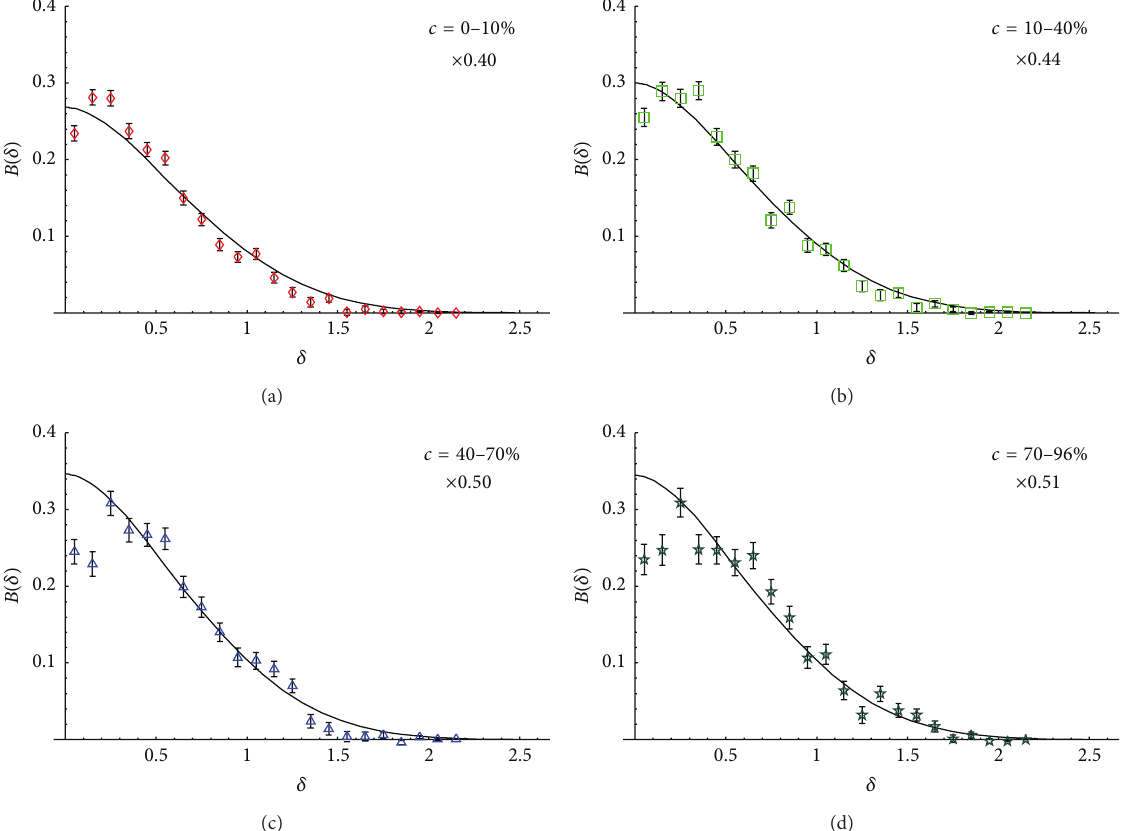
Figure 12: The balance functions for pions in the thermal model calculated for four different centralities are compared to data [25], 𝛿 ≡ Δ . The graph is taken from